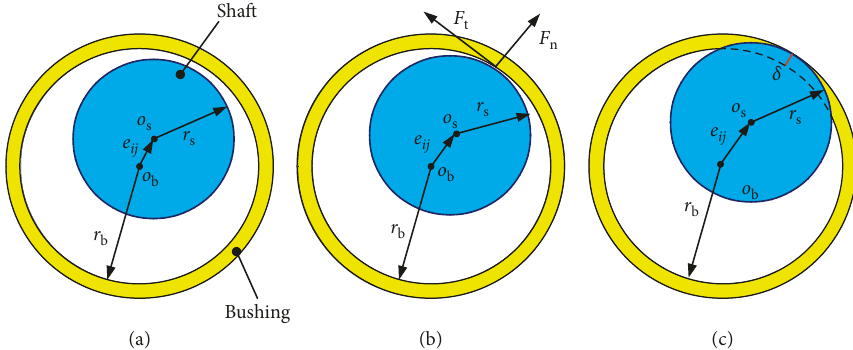
Figure 2: Position between shaft and bushing. (a) Separation. (b) Contact. (c)